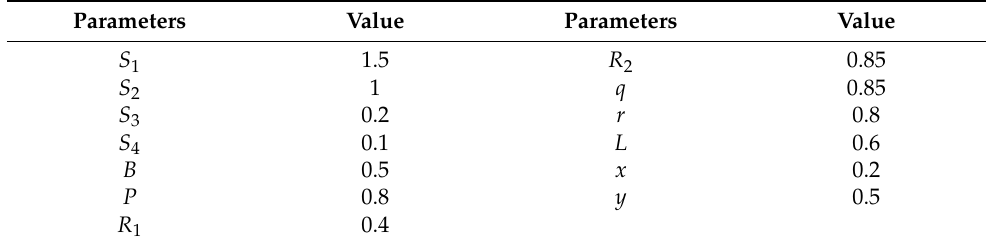
Table 7. The initial value of the game model. Parameters